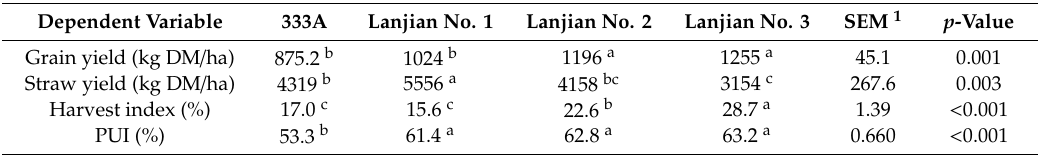
Table 2. Influence of variety on grain yield, straw yield, harvest index, and potential utility index (PUI) of four common vetch